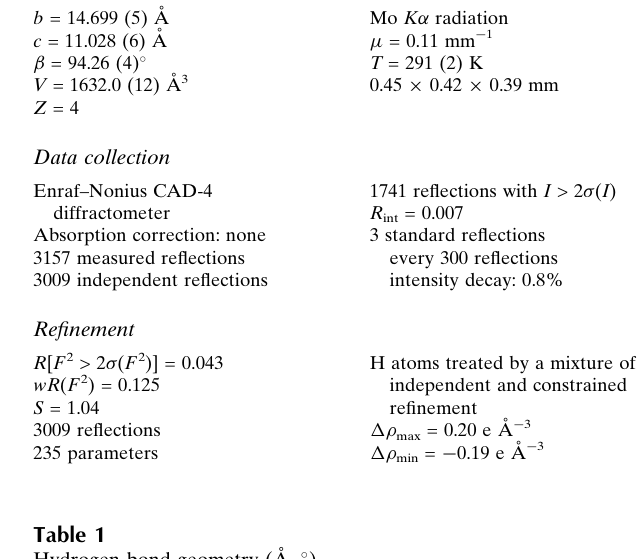
Hydrogen-bond geometry (A˚ , (cid:2)